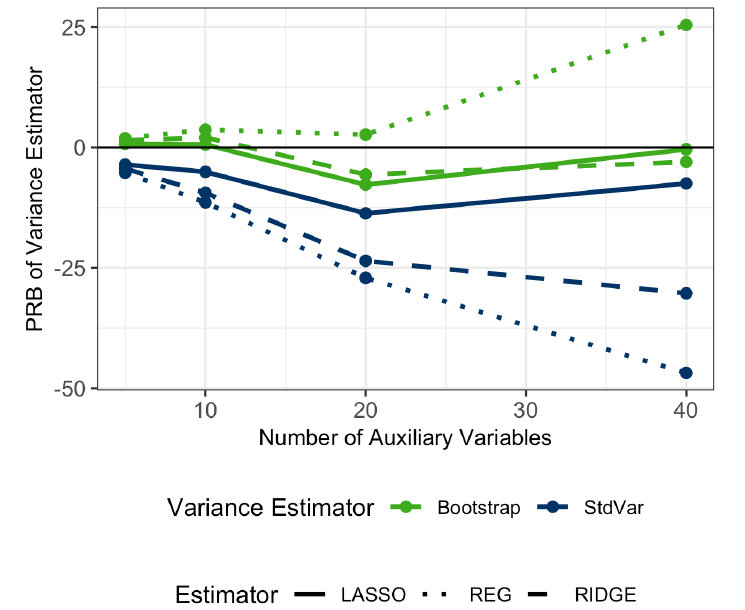
Figure 7. Percent relative bias (PRB) of variance estimators for REG, LASSO, and RIDGE as the number of predictors increases.